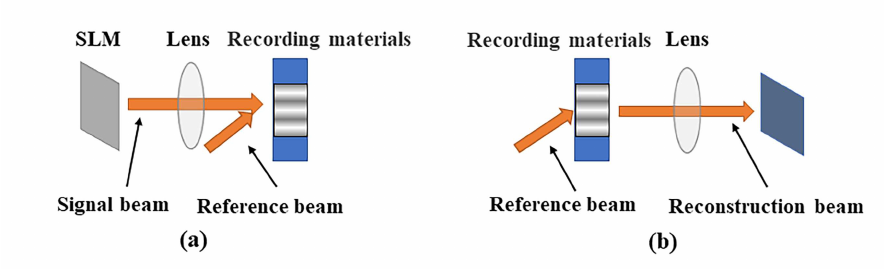
Figure 1. Principle of the holographic recording and reading process: ( a ) holographic recording process; ( b ) holographic reconstruction process, SLM, spatial light modulation.